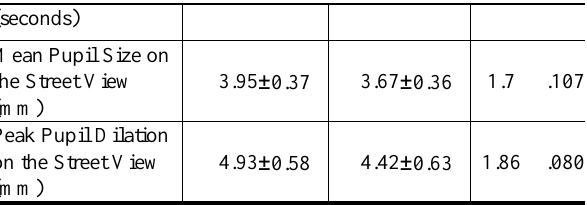
Table 1. Descriptive and inferential statistics of effectiveness, efficiency and cognitive load of the 2D and 3D groups during Task #2 (map reading before navigation).